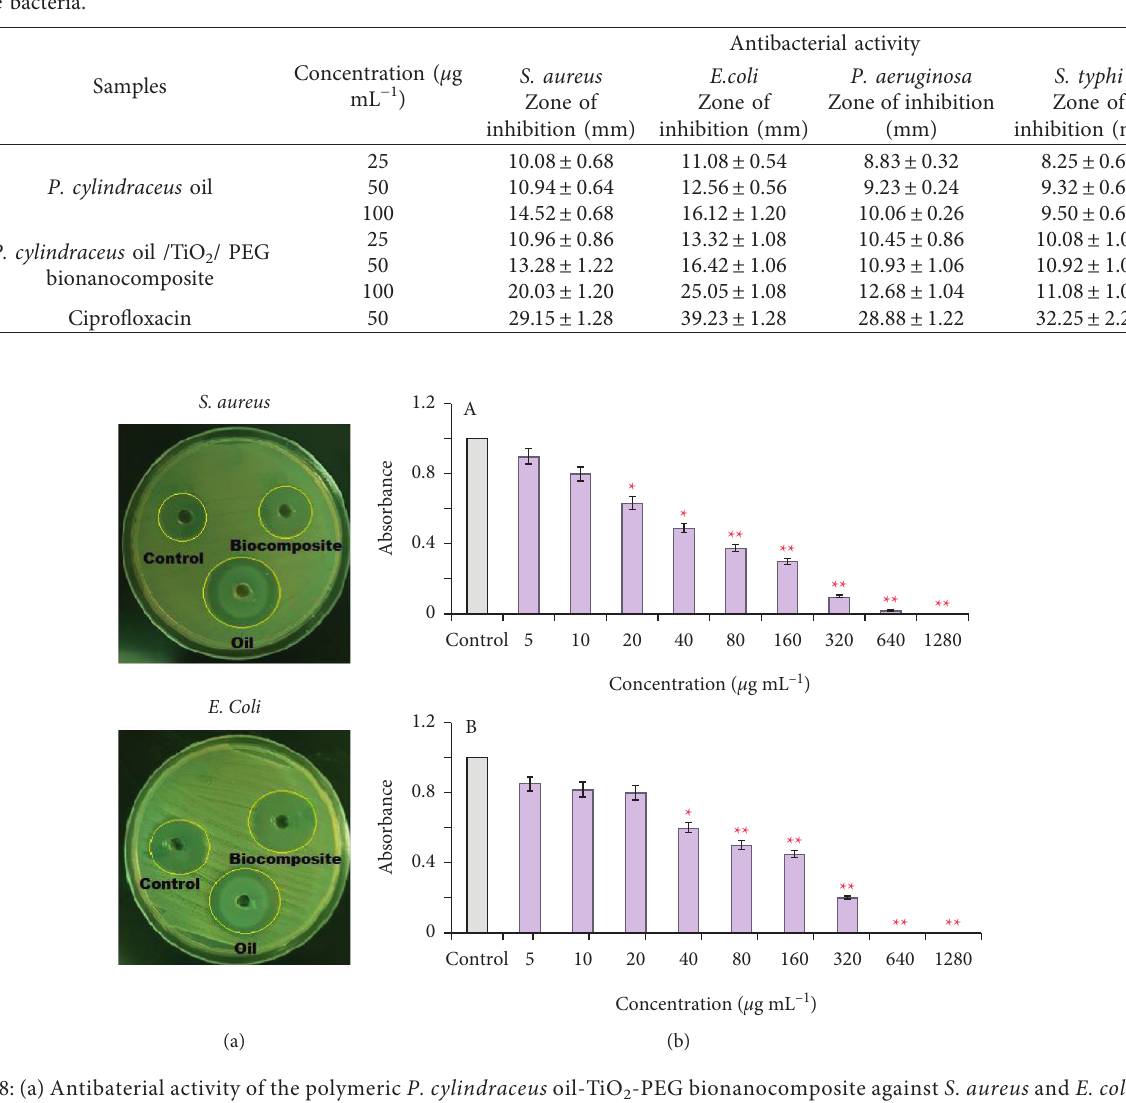
2 / PEG bionanocomposite against gram positive and gram